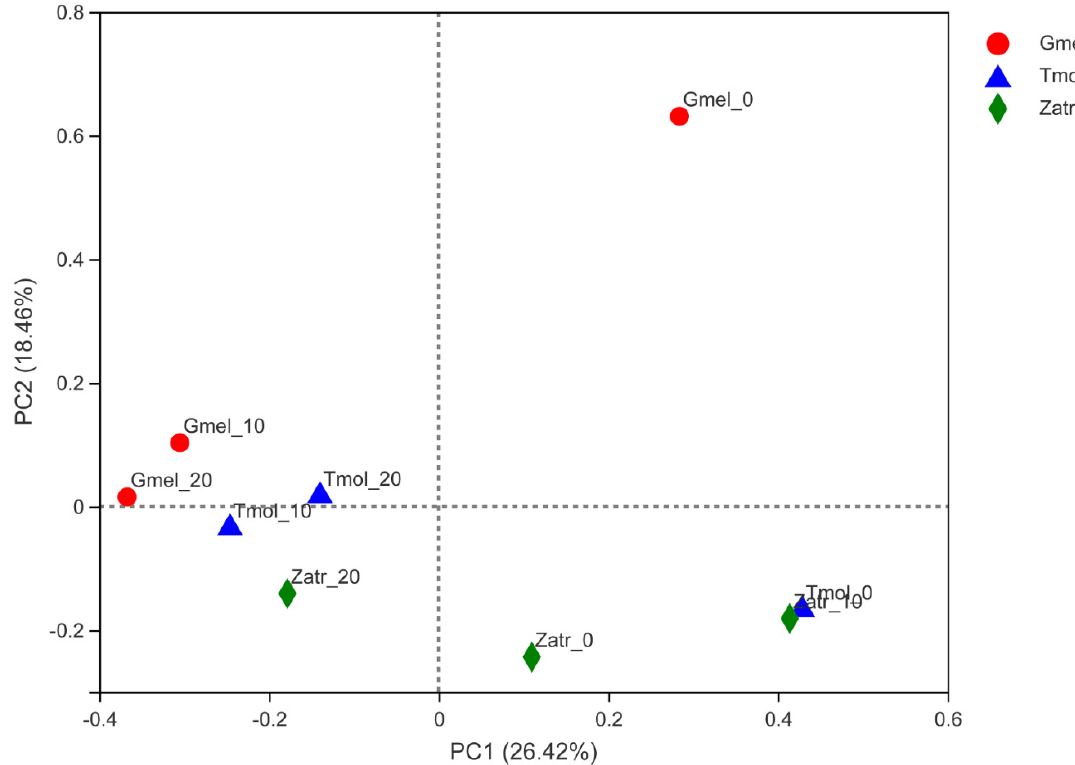
Figure 3. Principle co-ordinates analysis based on the Bray–Curtis distance among the nine groups of the three species’ larvae. Tmol: yellow mealworm, Gmel: greater wax moth, Zatr: superworm.